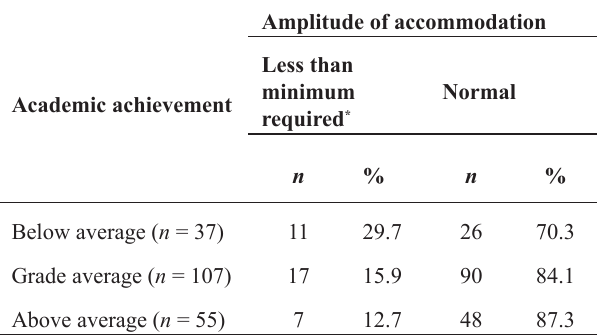
Table 3: Amplitude of accommodation in association with academic achievement.